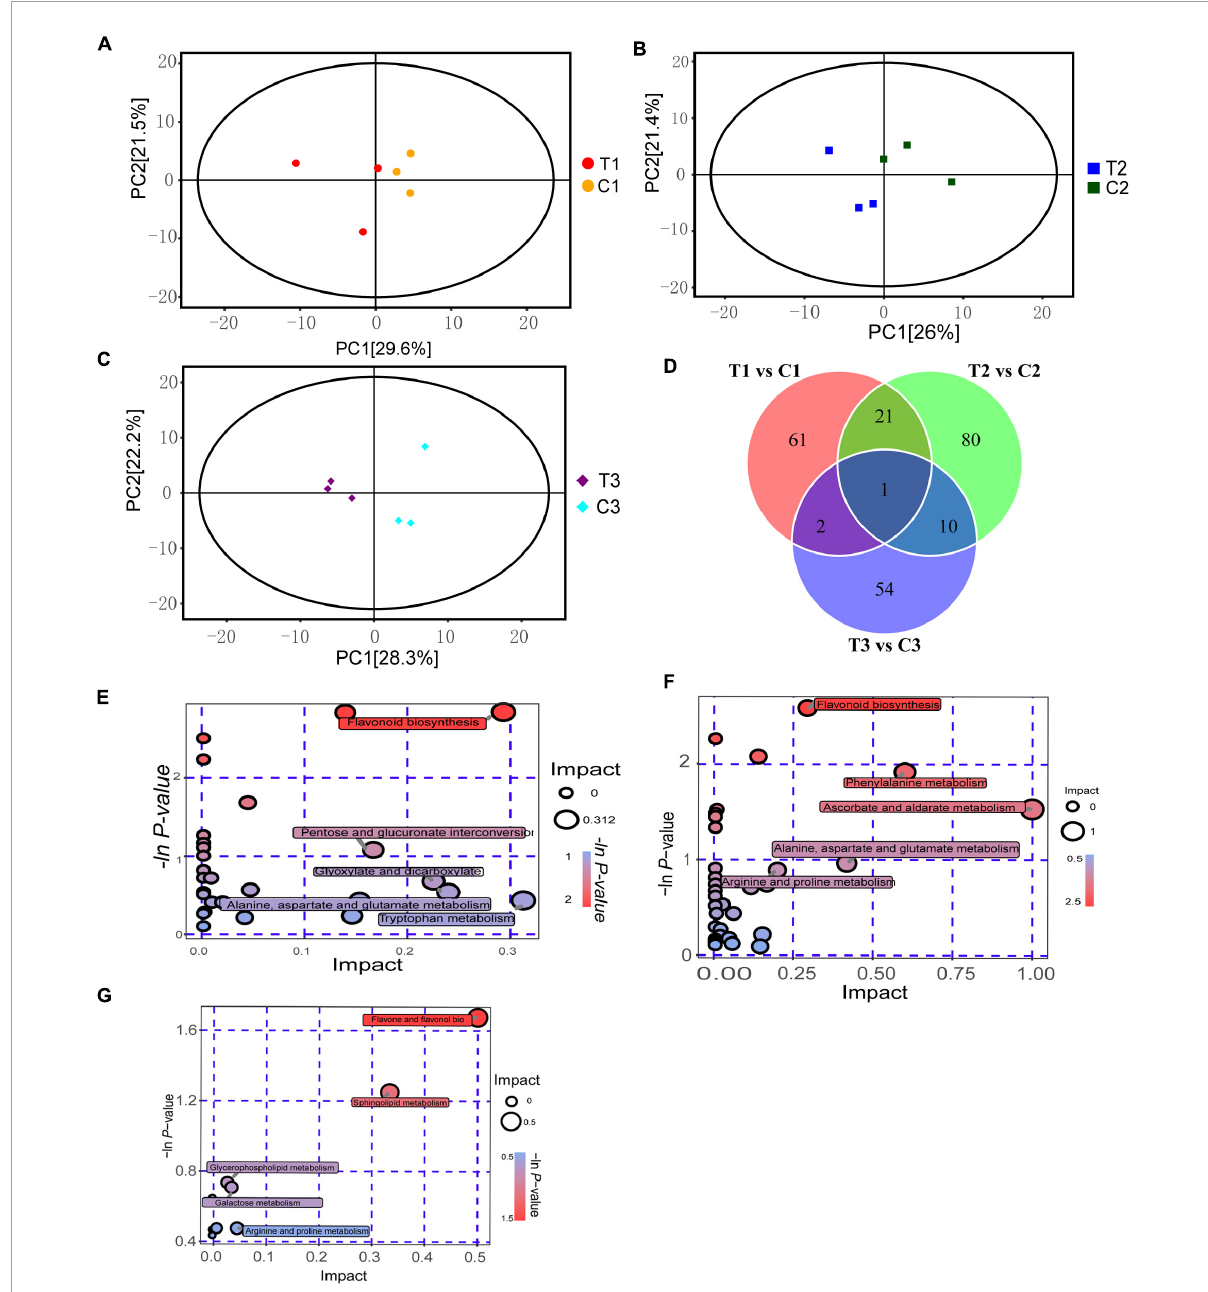
FIGURE2 Metabolomics analysis on dormancy release of epicotyl in P. cyrtonema seeds. (A) PCA analysis of T1 vs. C1. (B) PCA analysis of T2 vs. C2. (C) PCA analysis of T3 vs. C3. (D) Venn diagram of metabolite distributions across different stages. (E) KEGG analysis of T1 vs. C1. (F) KEGG analysis of T2 vs. C2. (G) KEGG analysis of T3 vs. C3.